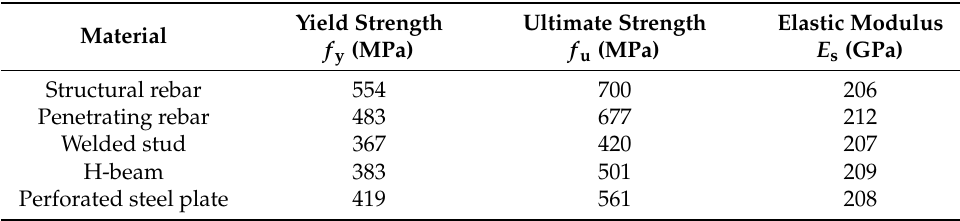
Table 2. Mechanical properties of materials.